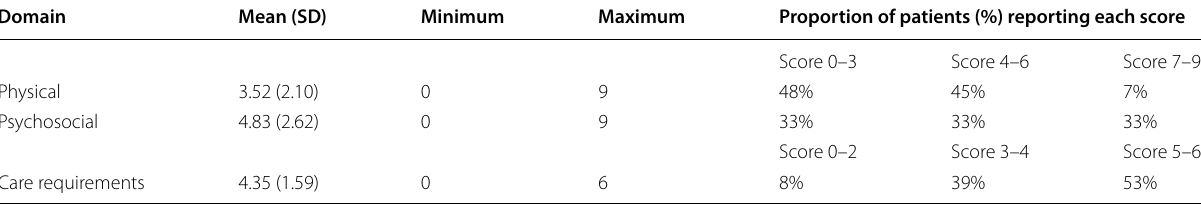
Table 2 Distribution of physical, psychosocial, and care requirement domain scores in survey sample ( n